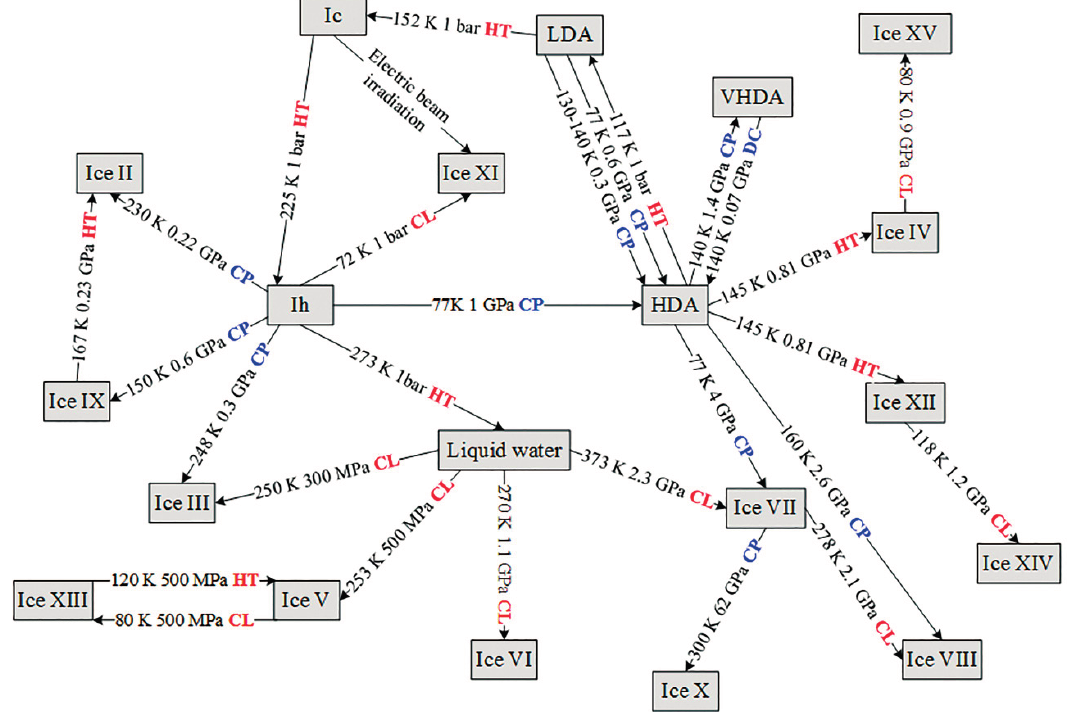
Figure 4. Schematic of 29 phase transition processes between different water phases. The temperature and pressure for the phase transitions are shown in the center of the arrows, and the 11 processes labeled with CP or DC in blue denoting as compression or decompression, respectively, are characterized by pressure dependence. While, the 17 processes labeled with HT or CL in red representing for heating or cooling, respectively, have the feature of temperature